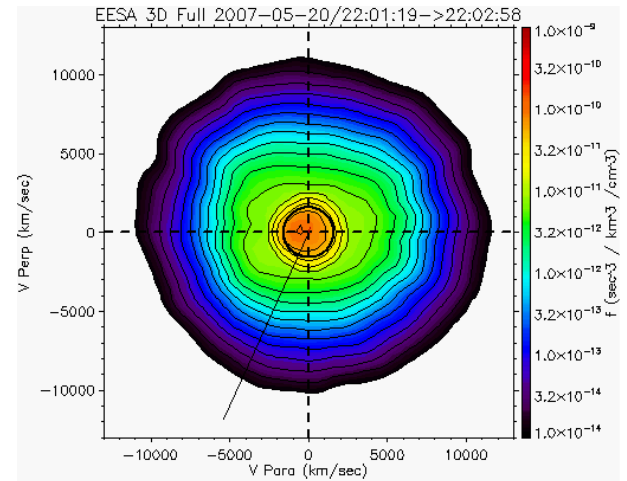
Fig. 8. Iso contours of the electron phase space density from Thd. At medium energies (green) evidence is given for T e // >T e ⊥ . Dis- regard the central region (red) which is influenced by photoelec-